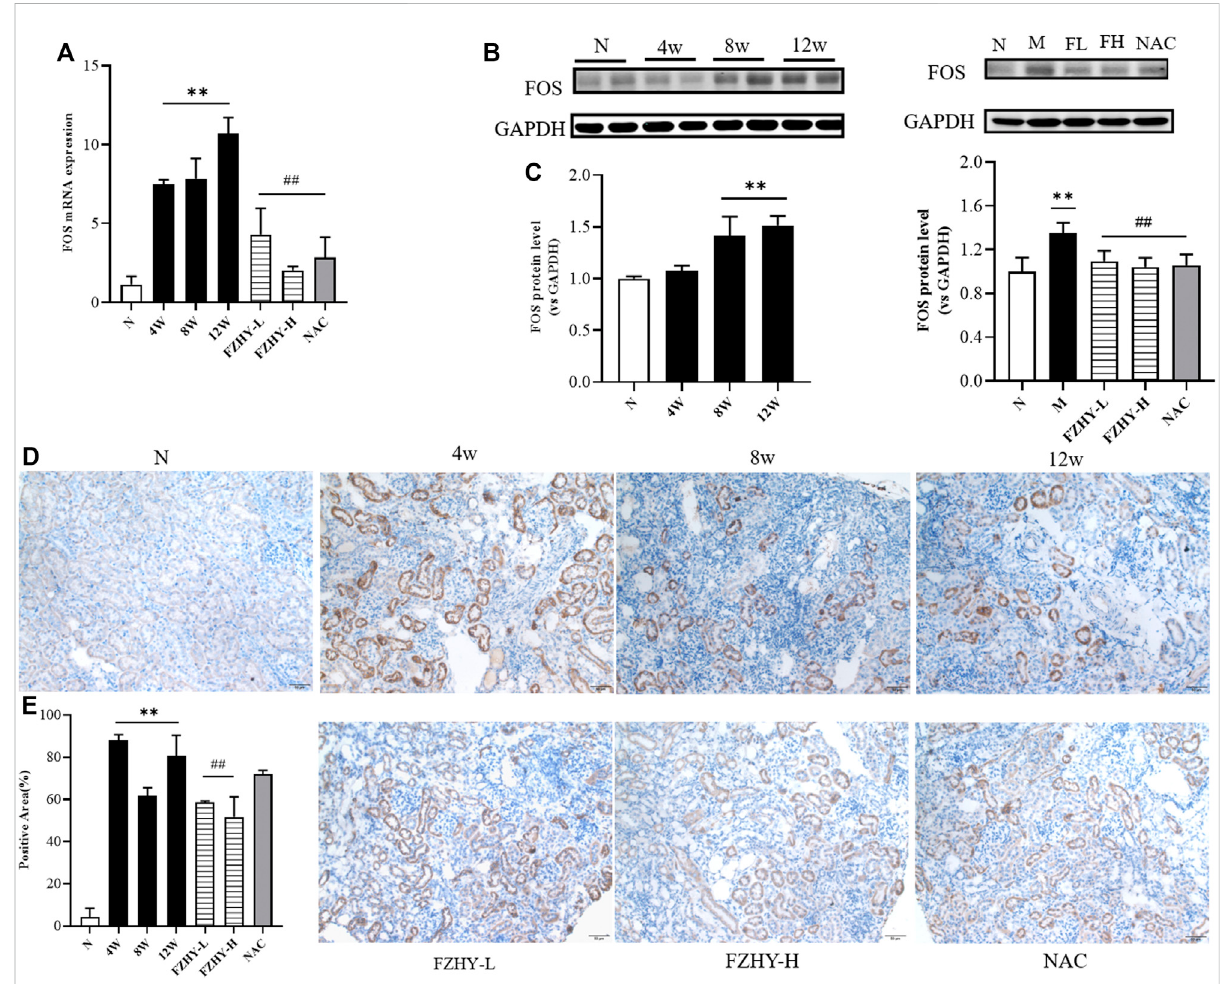
FIGURE 5 FOS may serve as key gene for FZHY to act on chronic kidney disease. Dynamic experimental model mice were intraperitoneal injected with Aristolochic Acid I (AAI) (4 mg/kg body weight) twice a week and sacri fi ced at 4 weeks, 8 weeks, and 12 weeks, respectively. Pharmacodynamic experimentalmodelmicewereintraperitonealinjectedwithAAI(4 mg/kgbodyweight)twiceaweekfor12 weeks.FromfourthweekofAAIinjection, mice were intragastrically administered FZHY (1.44 g/kg, 2.88 g/kg body weight) or NAC (3.0 g/kg body weight) per day for 8 weeks. All mice were sacri fi ced. Quantitative real-time polymerase chain reaction analysis of mice renal tissues (A) shows that FOS gene expression signi fi cantly increased at 4 weeks, 8 weeks, and 12 weeks compared with normal group and decreased after use of FZHY. Western blot exhibited (B) FOS protein expressioninmicerenaltissue. FOS proteinsigni fi cantlyincreasedat8 weeksand12 weekscomparedwithnormalgroupanddecreasedafterahigh dose of FZHY or NAC (C) . Immunohistochemistry was used for locating FOS protein (D) and quantifying (E) in paraf fi n sections of mice renal tissue. FOS proteinismainlyexpressedintubularepithelialcells,mostlyincytoplasm,andsomeareexpressedinnucleus.Bar=50 μ m;* p < 0.05,compared with normal group; ** p < 0.01, compared with normal group; # p < 0.05, compared with model group; ## p < 0.01, compared with model